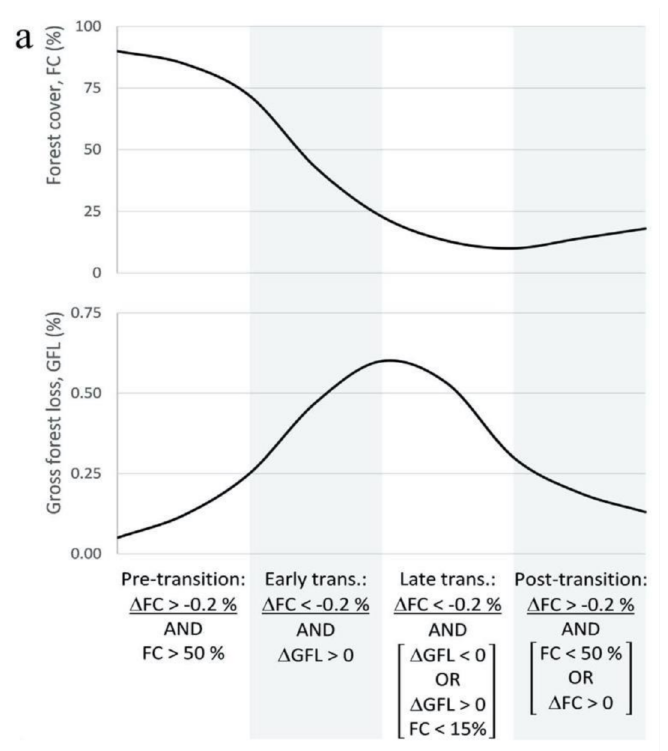
Figure A1. Forest transition countries’ classification. Source: Pendrill et al. [26] (p. 6).